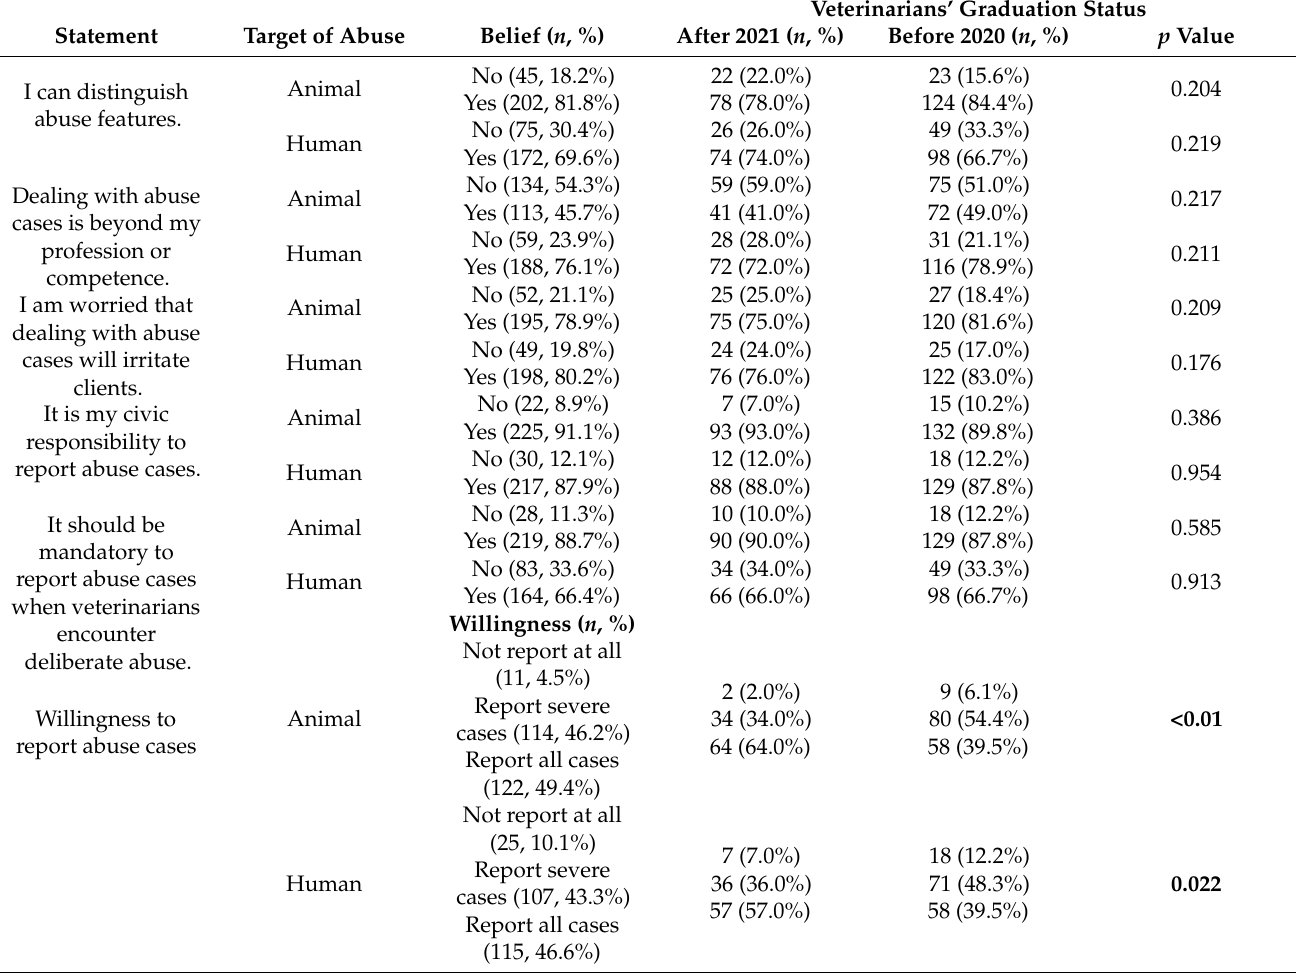
Table 8. A comparative analysis of management of abuse and veterinarians’ graduation status. Veterinarians’ Graduation Status